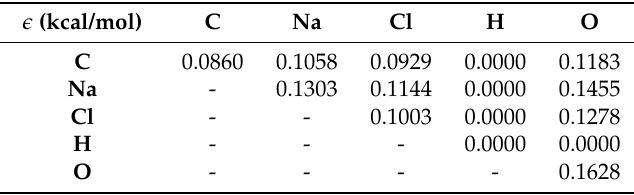
Table 2. Parameter ɛ in the Lennard-Jones potential. Table 2. Parameter (cid:101) in the Lennard-Jones potential.